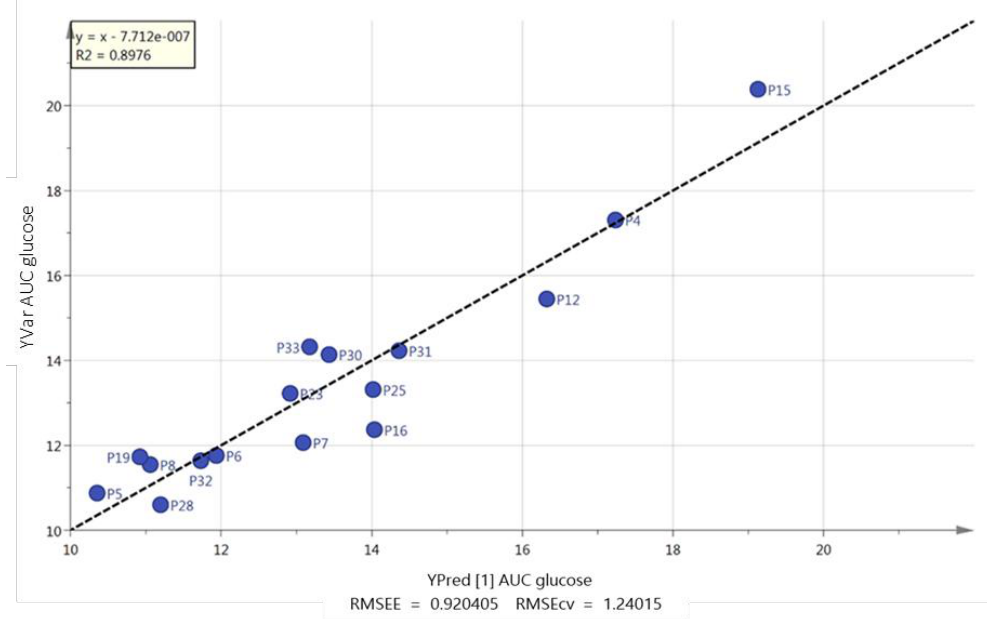
Figure 5. OPLS of predicted vs. actual area under the curve (AUC) for glucose based on four free fatty acids palmitate, oleate, eicosatrienoic acid and docosahexenoic acid.